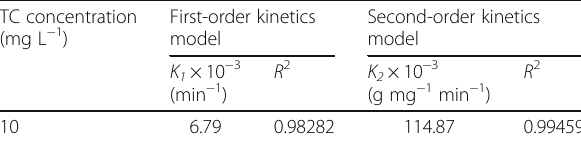
Table 1 Kinetic models and related parameters used to fit the curves of adsorption